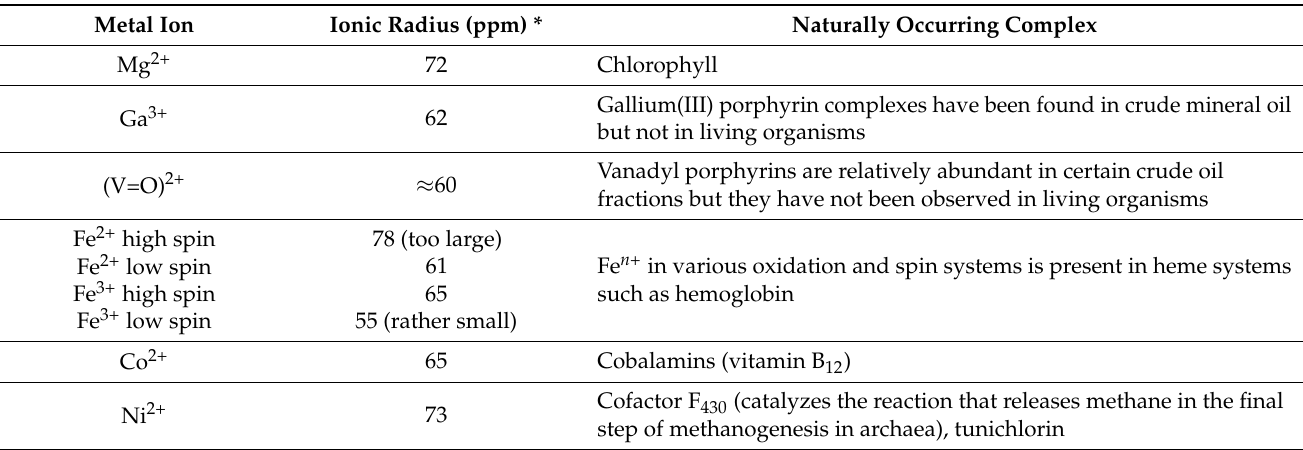
Table 1. Naturally occurring metalloporphyrin complexes